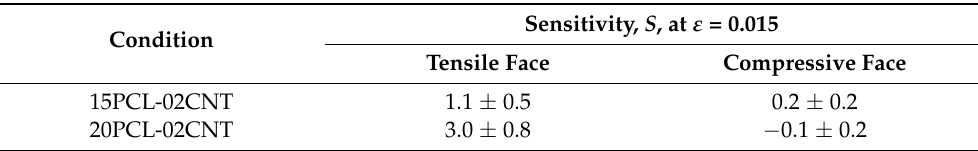
Figure 7. Electromechanical response of ( a ) 15PCL-02CNT and 20PCL-02CNT samples with ( b ) a prevalent compressive failure and ( c ) mixed tensile-compressive failure, where the micrographs on the left denote the transversal sections. Table 3. Sensitivity values at the compressive and tensile face for CNT-reinforced PCL/epoxy/GF composites during the bending